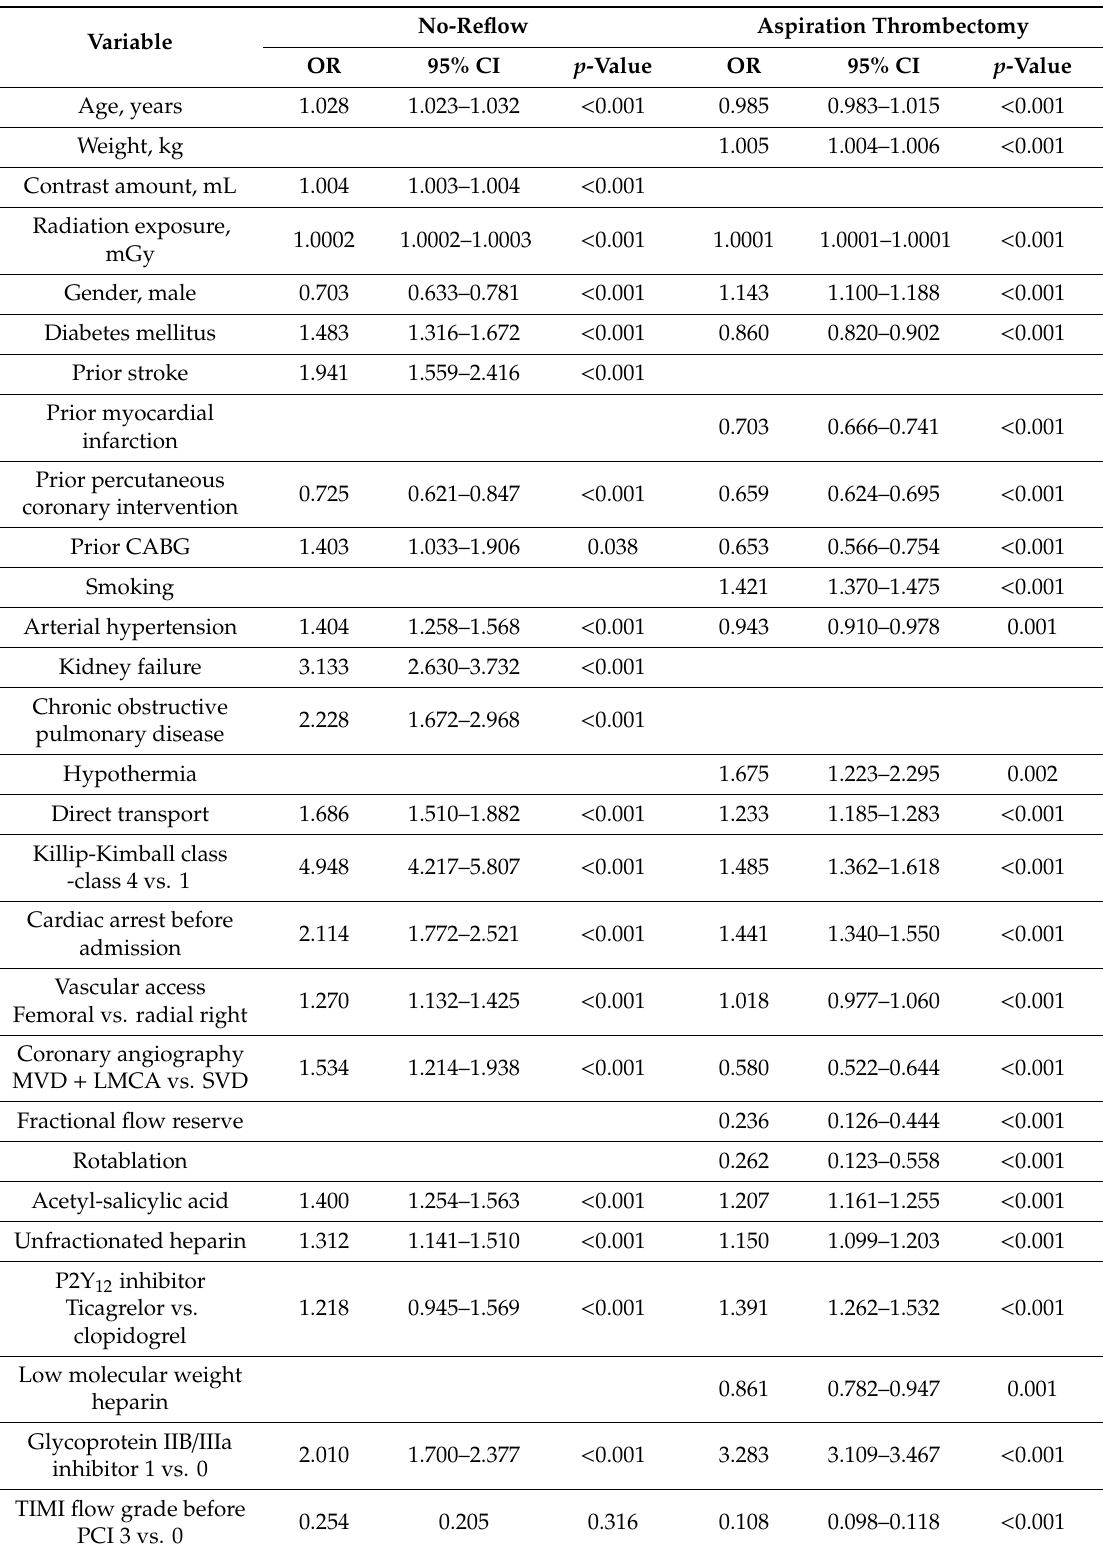
Table 5. Predictors of aspiration thrombectomy and no-reflow in patients with STEMI— univariate